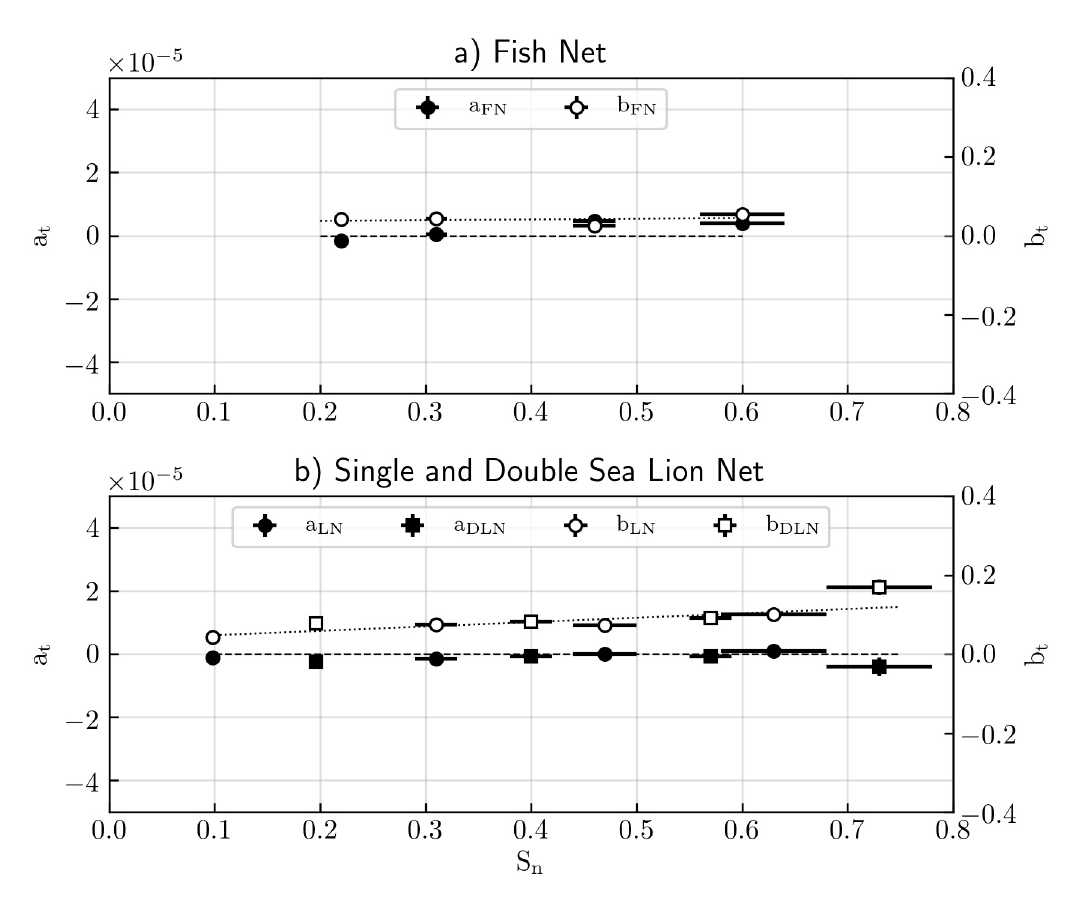
Figure 10. Coefficients a and b of the linear fit with Reynolds number of the tangential drag coefficient for ( a ) fish net and ( b ) double or single sea lion nets as a function of the solidity index. Experimental series, clean or without fouling, from Table 1. Dashed lines represent a linear fit of the